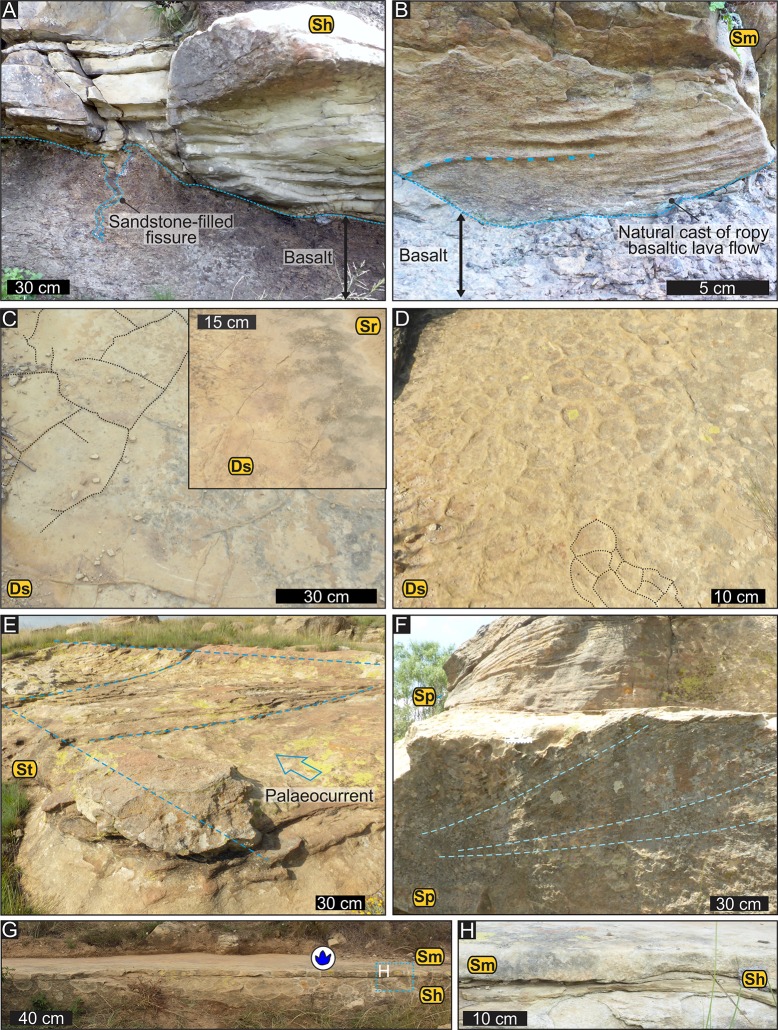
Sedimentary features associated with the sandstone interbeds on Highlands.(A) Horizontally laminated sandstone interbed unit overlying the basalt with a sandstone-filled fissure and a sharp but non-erosional contact. (B) Ropy-surface texture of pahoehoe lava flows preserved as a natural cast on the underside of a massive sandstone bed. These casts of the ropy-basalt surface suggest that the deposition of the sandstone interbeds occurred in non-erosive, and possibly rapid sedimentation events. (C) Casts of fine desiccation cracks and interference ripple marks (in the inset). (D) Casts of coarse desiccation cracks. (E) Large-scale trough cross-bedding in a 40-cm-thick medium-grained sandstone layer. (F) Planar cross-bedding with tangential, moderately inclined foresets in a ~ 120-cm-thick medium- to fine-grained sandstone layer. (G) Side-view of the track-bearing massive sandstone layer and underlying horizontally laminated sandstone bed. (H) Close-up of portion of G. Abbreviations: Sh–horizontally laminated sandstone; Sm–massive sandstone; Sr–ripple marks or ripple cross-laminated sandstone; St–trough cross-bedded sandstone; Sp–planar cross-bedded sandstone; Ds–desiccation cracks.